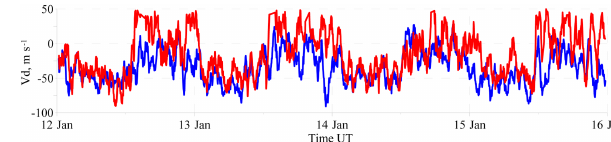
Figure 9. Estimated plasma drift velocity (line of sight) at 250km (blue) and 350km (red)